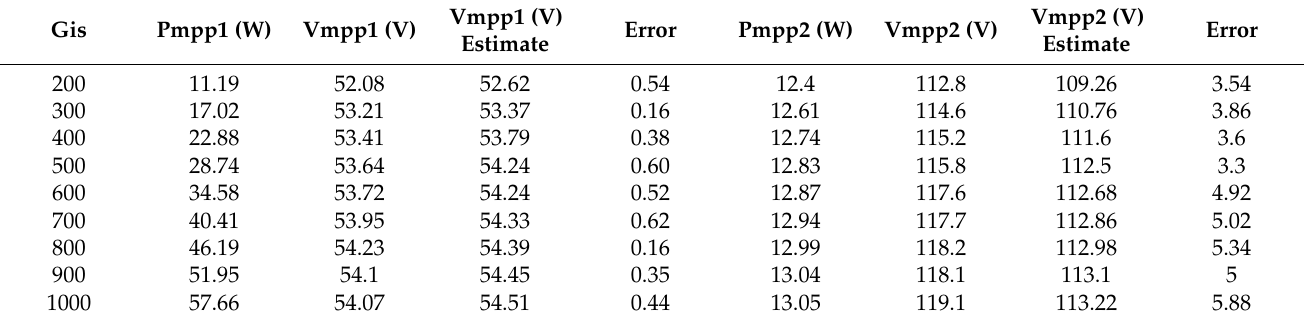
Table 5. The P-V characteristic data for test 3.